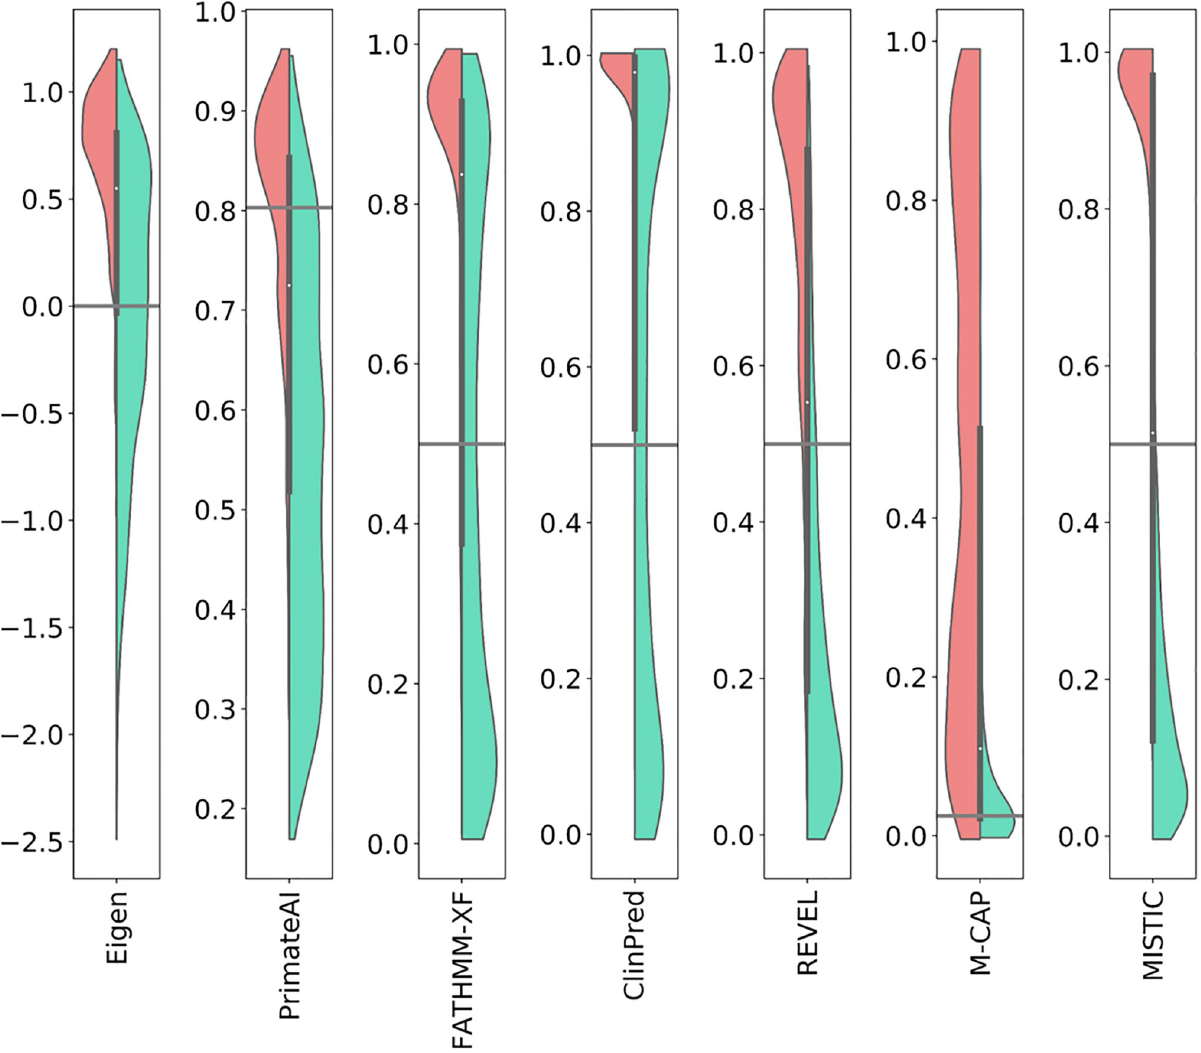
Fig 4. Distribution of scores for deleterious and benign variants. The variants of the deleterious (Del_EvalSet) and benign sets with MAF (Benign_EvalSet) were pooled and the distribution of the scores for deleterious and benign variants were represented using violin plots. Red area– distribution of scores for deleterious variants. Green area–distribution of scores for benign variants. Black line–recommended threshold.